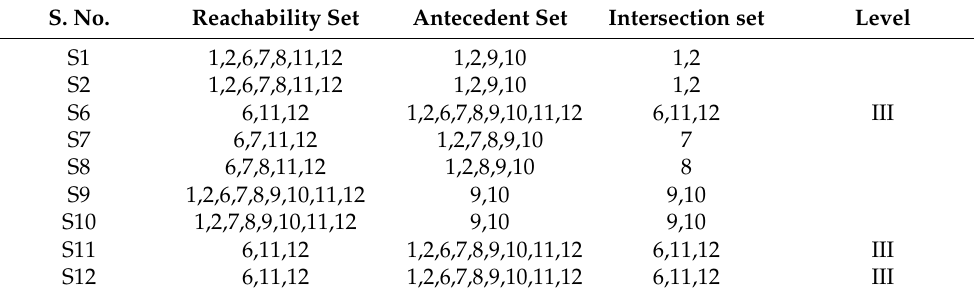
Table A3. Level partitions (Iteration III).